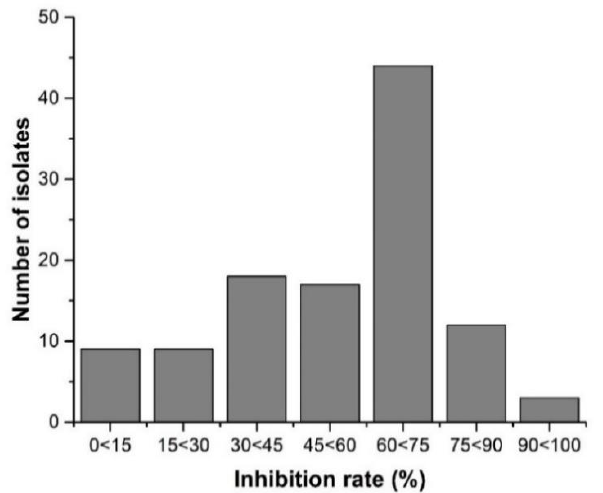
Figure 1. The inhibition rate of B. cinerea isolates against iprodione (0.01 µg/mL) collected from different areas of Guangxi Province China.